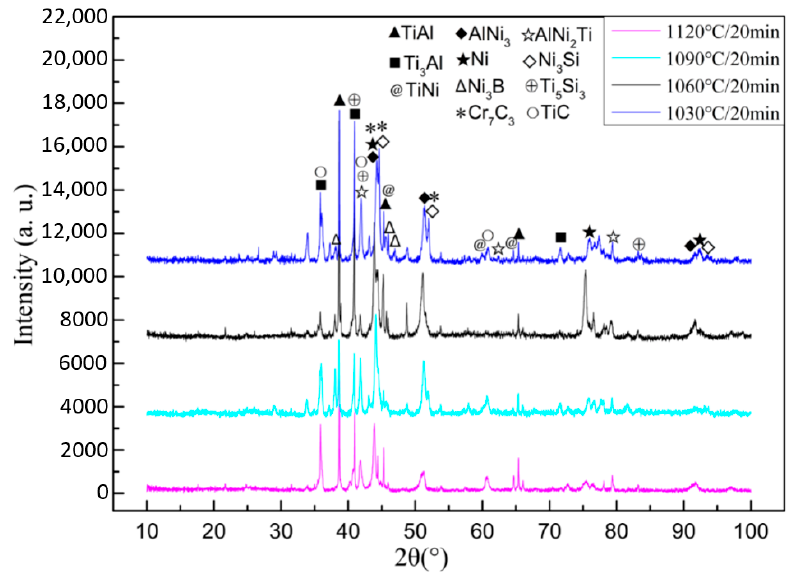
Figure 7. XRD test results of TiAl side under different brazing processes.